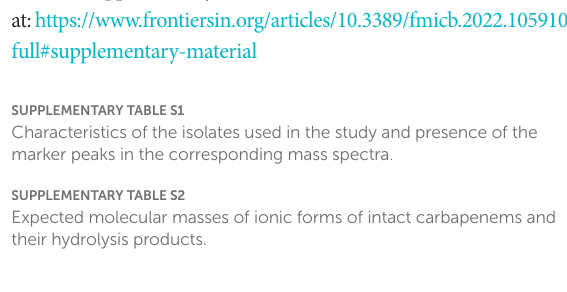
marker peaks in the corresponding mass spectra. SUPPLEMENTARY TABLE S2 Expected molecular masses of ionic forms of intact carbapenems and their hydrolysis